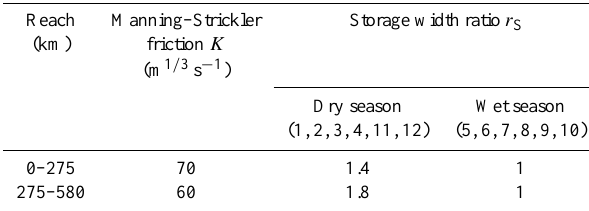
Table 4. Calibrated parameters used in the analytical